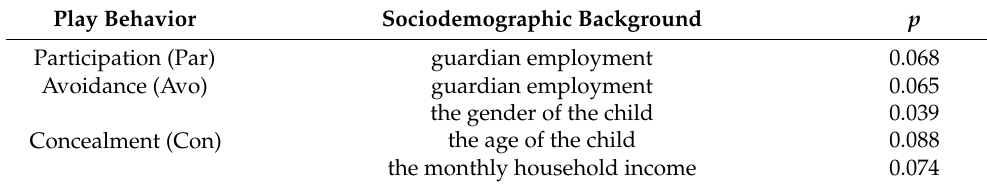
Table 6. The impact of sociodemographic background on play behavior of children with ASD. Play Behavior